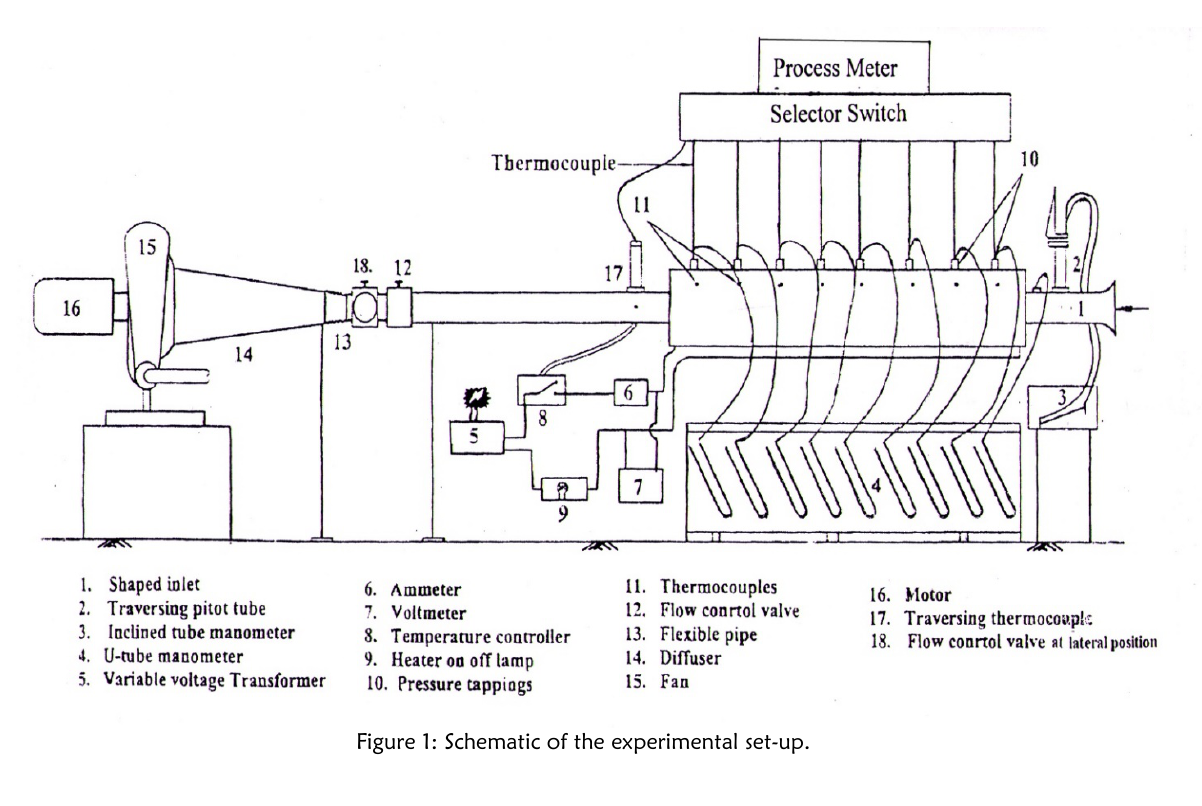
Figure 1: Schematic of the experimental set-up.